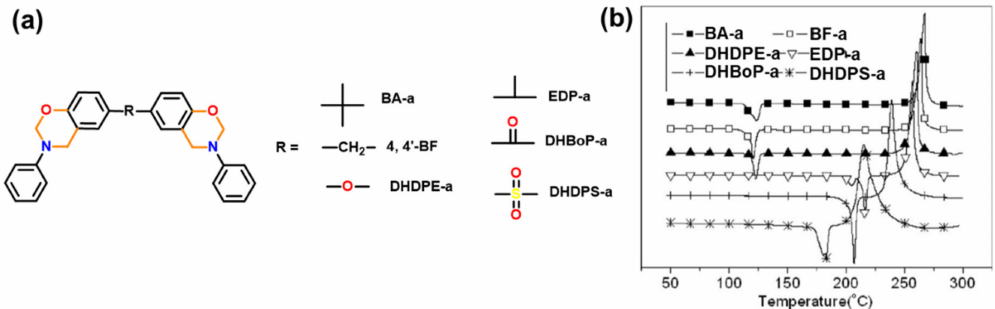
Figure 64. ( a ) Variation in biphenyl linkage in bisphenol based bis-benzoxazine monomers and their ( b ) DSC thermo- grams [400]. Copyright 2011. Reproduced with permission from Wiley Periodicals,